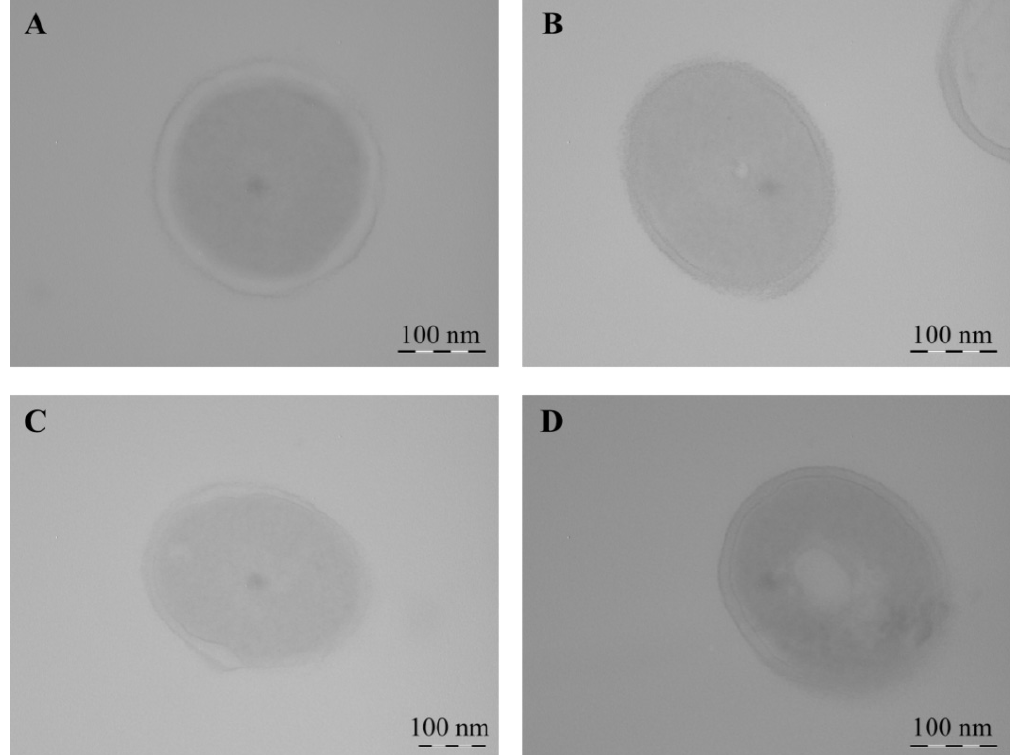
Figure 15. TEM micrographs of Cms bacteria in the control ( A ) and treated with AG-Mn ( B ), AGS-Mn ( C ), and κ -CG-Mn ( D ). Transverse optical section of cells.